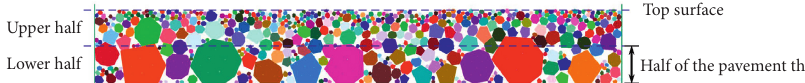
Figure 17: Illustration of the upper and lower half of rockfill pavement.